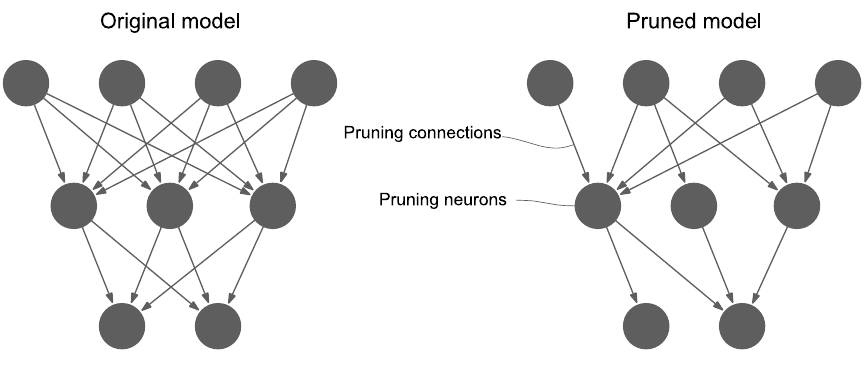
Figure 14. Model